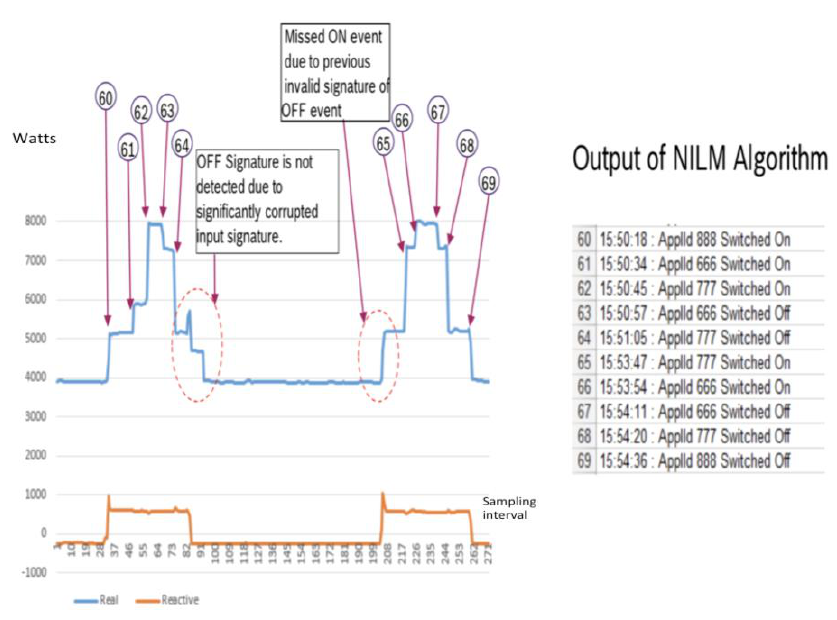
Figure 13. The load identification of different loads learned by the NILM program.